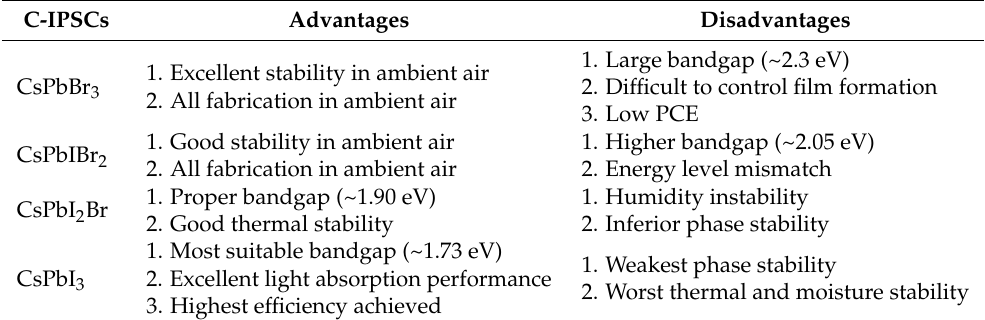
Table 2. A summary of the advantages and disadvantages of different C-IPSCs.